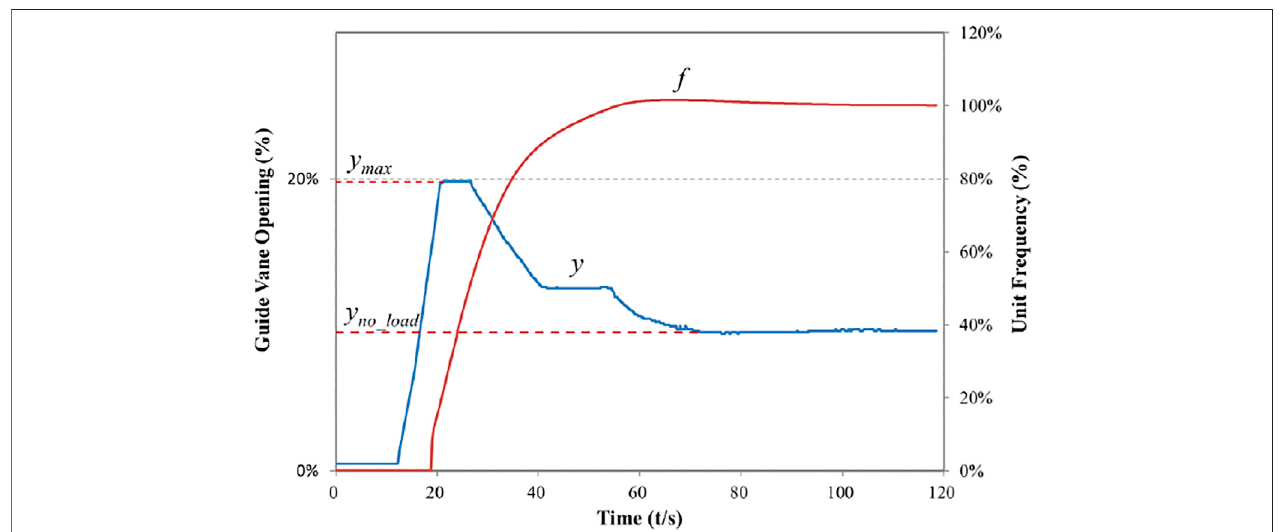
FIGURE 1 | The common change process of the guide vane opening for hydropower